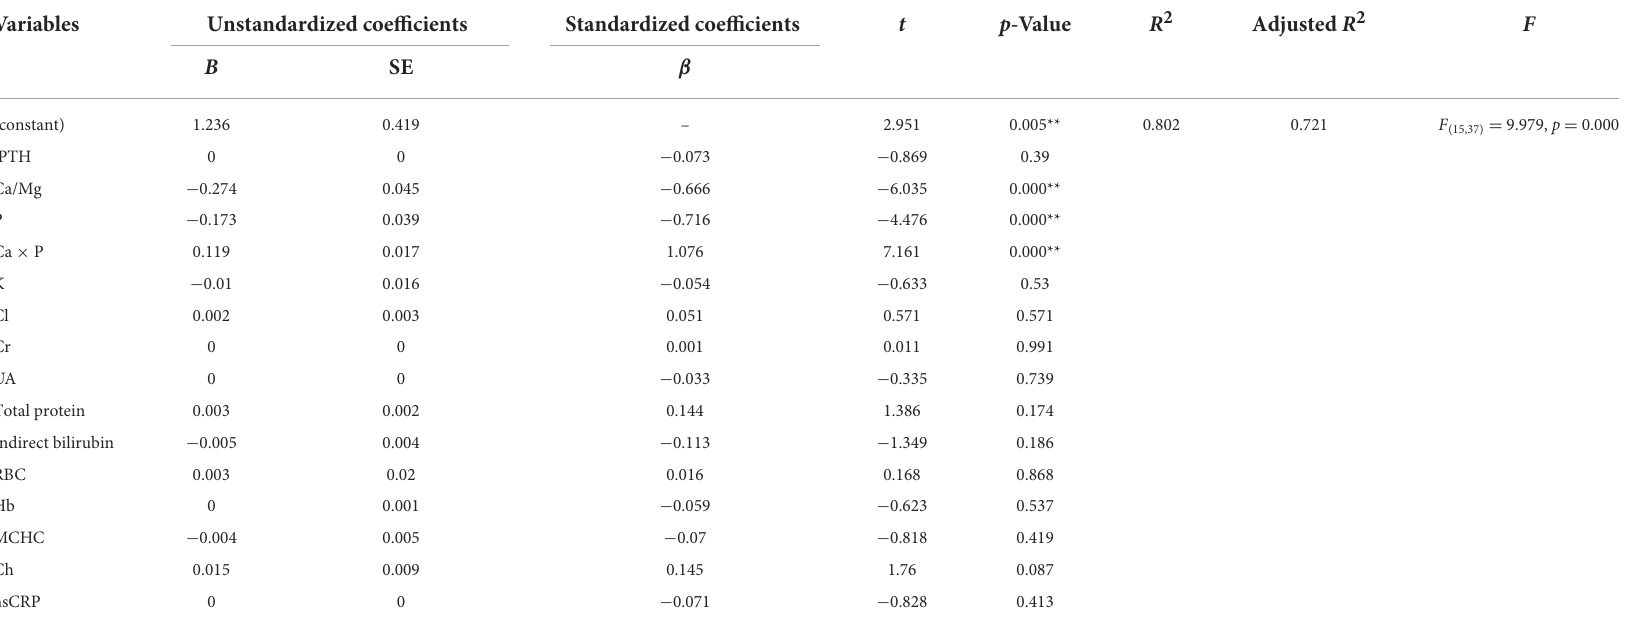
TABLE 4 Results of Ridge regression analysis in 123 HD